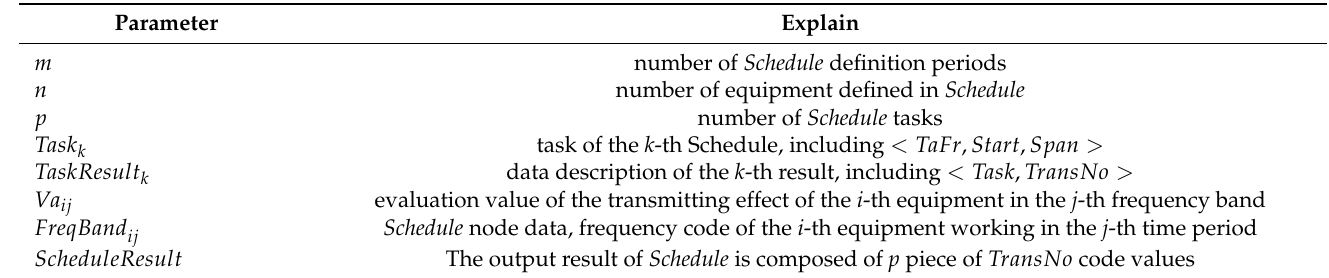
Table 1. Parameter table of DSTT mathematical model.